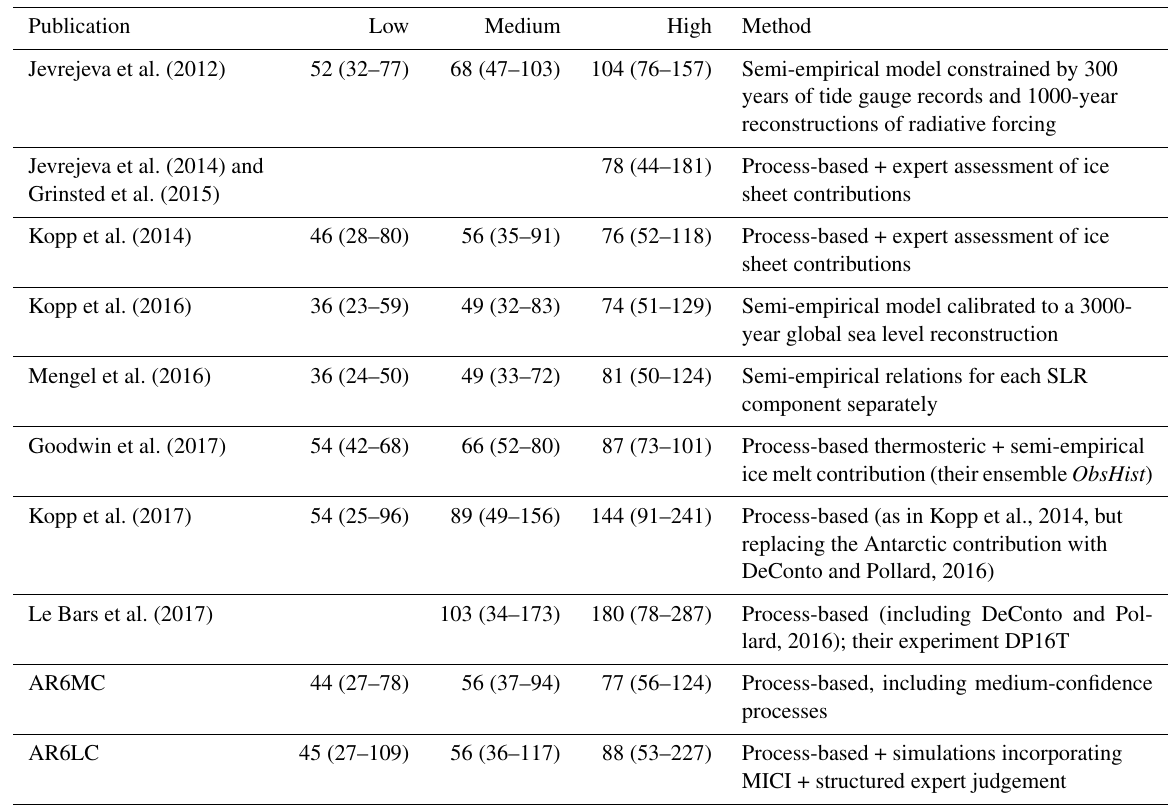
Figure 2. Schematic illustration of the method. A set of global mean sea level rise (GMSLR) projections is normalized to a common time span. Probability distributions are fitted to each projection and combined to produce a probability distribution of sea level rise (SLR), then combined with land uplift and wind-induced changes to produce local relative mean sea level (MSL) projections. This calculation is performed separately for different emission scenarios. Table 1. Sea level rise projections used in this study: median values and 5%–95% ranges (in parentheses). All values are in centimetres in 2100 relative to 1995–2014. The low-emission scenario refers to RCP2.6/SSP1-2.6, medium to RCP4.5/SSP2-4.5, and high to RCP8.5/SSP5- 8.5. AR6MC and AR6LC are the medium- and low-confidence projections of IPCC AR6 (Fox-Kemper et al., 2021),